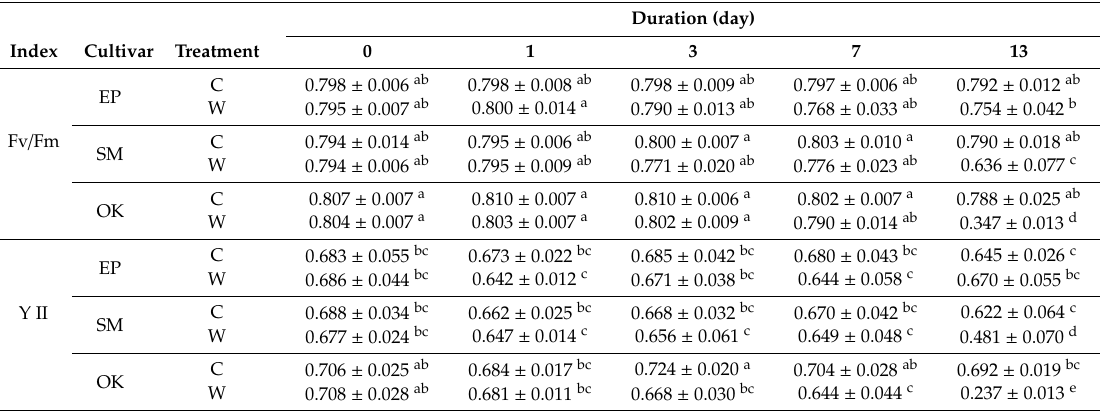
Table 3. E ff ects of waterlogging on variable / maximal fluorescence ( Fv / Fm ) and quantum photosynthetic yield (YII) values in EP, SM, and OK squash plants. Plants were grown under optimally irrigated (control, C) or waterlogging (W) conditions for di ff erent time